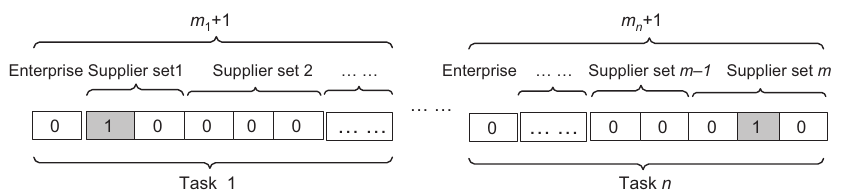
Figure 3. A feasible Chromosome Coding